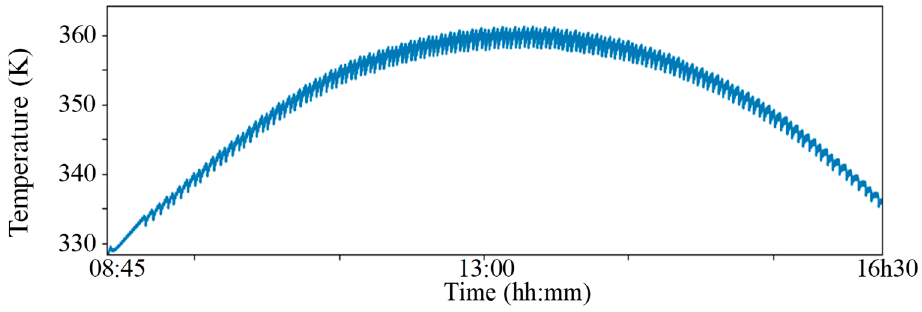
Figure 20. Simulated evaporator temperature over a sunny day.